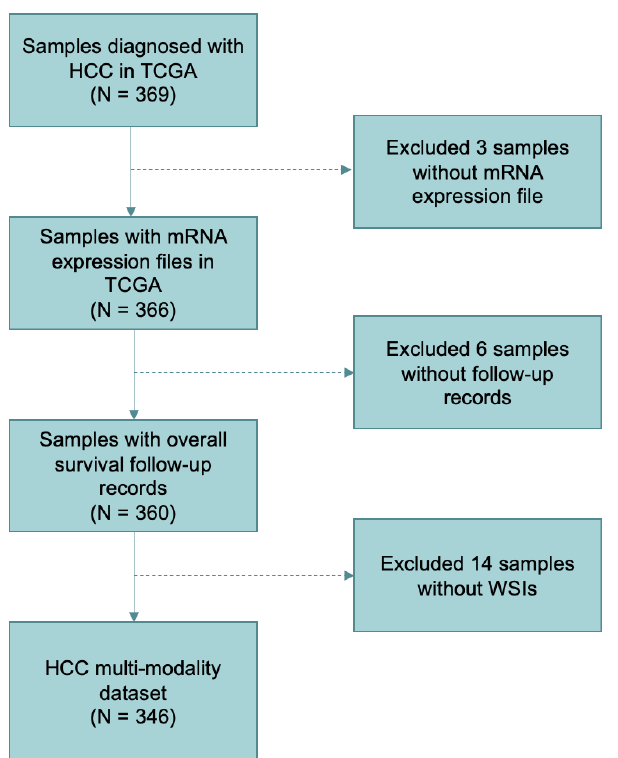
Figure 1. Sample screening and data organization flowchart in the study. A total of 346 patients were included in the datasets according to the selection criteria.